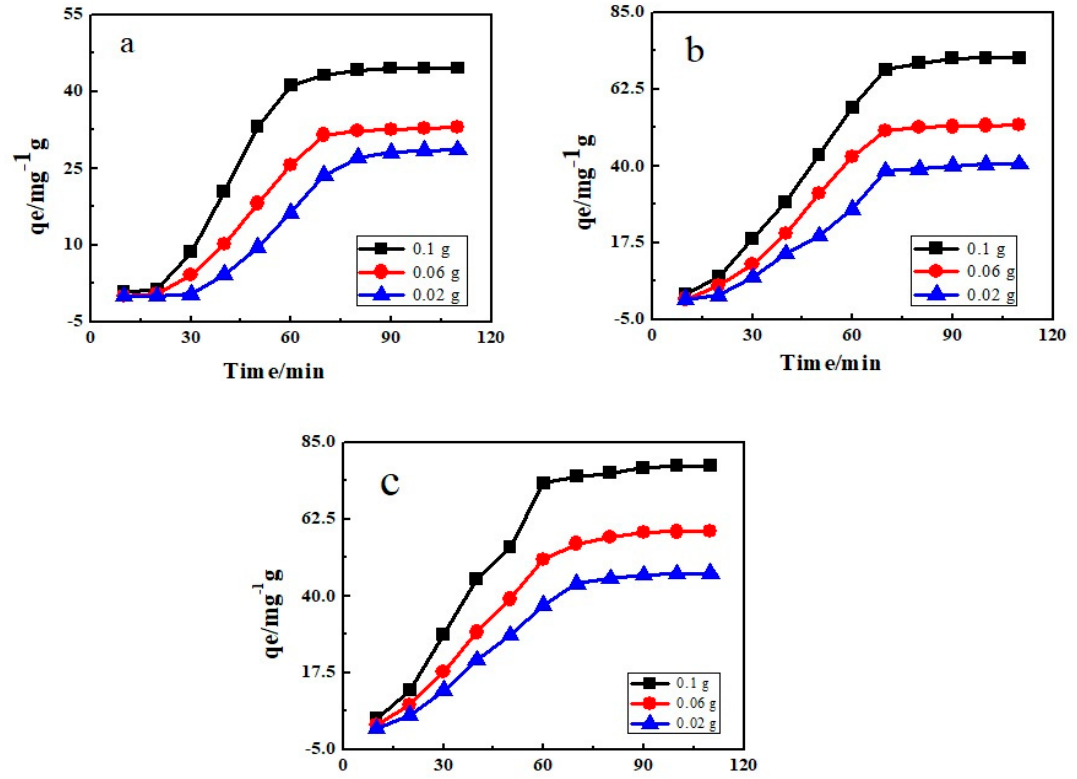
Figure 11. E ff ect of adsorbent dose for ( a ) Fe 3 O 4 , ( b ) PANI, and ( c ) PANI / Fe 3 O 4 composite on adsorption of Figure 11. Effect of adsorbent dose for ( a ) Fe 3 O 4 , ( b ) PANI, and ( c ) PANI/ Fe 3 O 4 composite on adsorption of BB3.